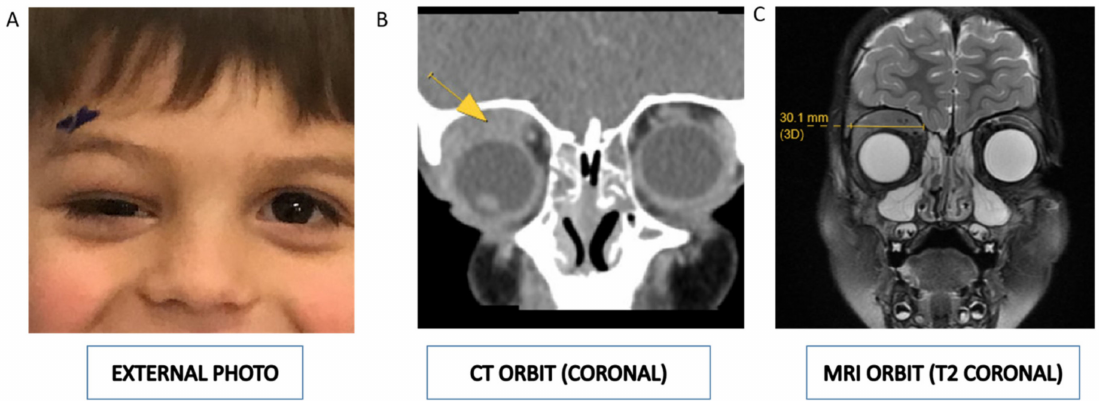
Figure 1. ( A ) External photograph demonstrating fullness of the right upper eyelid with downward displacement of the globe (hypoglobus). ( B ) Contrast-enhanced computed tomography and ( C ) magnetic resonance imaging of the orbit demonstrating a 3 cm by 1 cm mass (indicated by the yellow arrow in Figure 1B) of the right extraconal orbit, suspicious for hematologic malignancy or